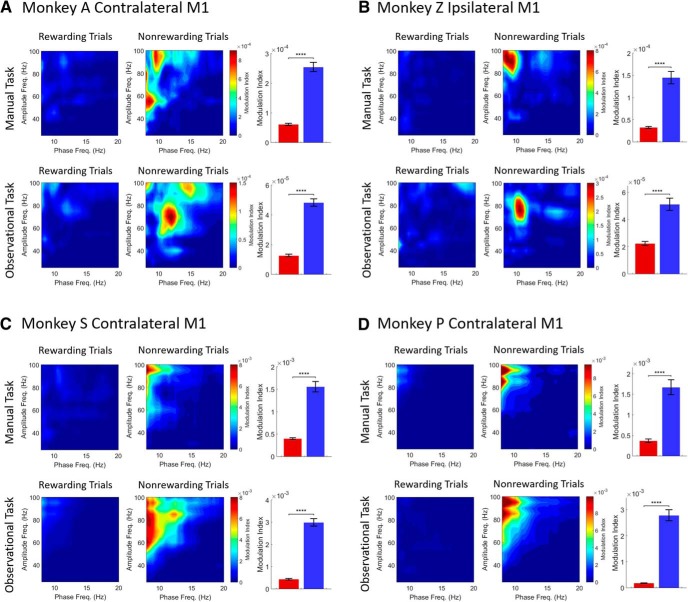
Comodulograms showing the MI for rewarding (left column in each subplot) and nonrewarding trials (middle column in each subplot) across manual (upper row in each subplot) and observational tasks (lower row in each subplot) for contralateral (A, C, D) and ipsilateral (B) M1 cortices. Bar graphs (right column in each subplot) show significant differences of α-γ MI values for rewarding (red) and nonrewarding (blue) trials (****p < 0.0001; Wilcoxon signed-rank test). Error bars in the bar plots represent SEM. A, B are for the center-out reaching tasks, and C, D are for the grip force tasks.